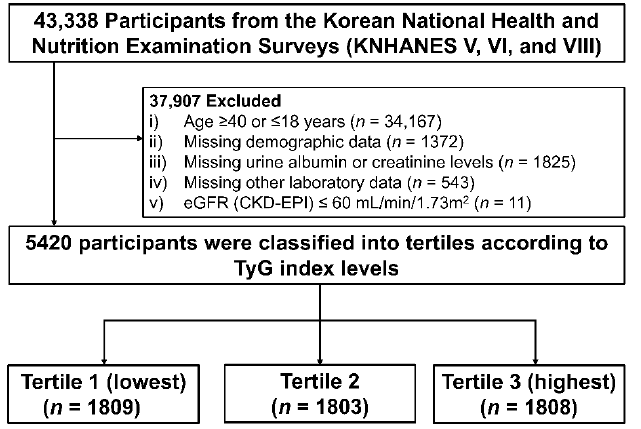
Figure 1. Flow chart of study population. Abbreviations: KNHANES—Korea National Health and Nutrition Examination Survey; TyG index—triglyceride-glucose index.